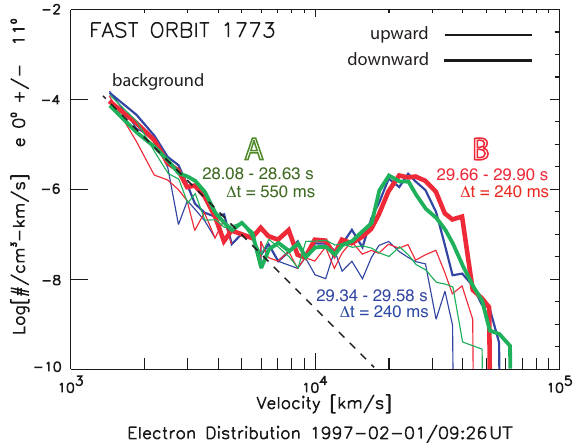
Fig. 5. The magnetic-field aligned electron velocity distribution in the auroral-kilometric radiation source above active aurorae during the observation time of Figs. 3–4 in the downward electron flux (upward current) region. Observation times are given at the curves. The dashed line indicates background fluxes. Upward (reflected) electrons (thin lines) and downward electrons (heavy solid lines) belong to three different time slices in Fig. 4. The two interest- ing slices are labelled A and B. Integration times 1t are indicated. These observations are typical for a downward ring-horseshoe dis- tribution with highest flux down along the magnetic field (panel 6 in Fig. 3). Clearly, the limited resolution does not resolve any electron holes. The electron distributions are cut off at high velocity. The highest velocity peak (caused by the two saturated high-energy red spots in slice B of Fig. 4) at the highest energy parallel ring dis- tribution B (red curve) may be due to formation of the accelerated cold electron beam which forms in the evolution of the electron hole (at plasma frequency of ω e / 2 π ≈ ( 1 . 5 − 2 ) × 10 3 Hz the integration time of 0.24s corresponds to ≈ 500 plasma periods, sufficient time for formation of holes and generation of the cold fast beam). This beam has maximum velocity V b ∼ 4 . 5 × 10 4 kms − 1 ∼ 0 . 15 c . The velocity of the ring-horseshoe is V R ∼ 2 . 5 × 10 4 kms − 1 . Its ‘ther- mal’ velocity spread is about 1V = v e ∼ 10 4 kms − 1 .